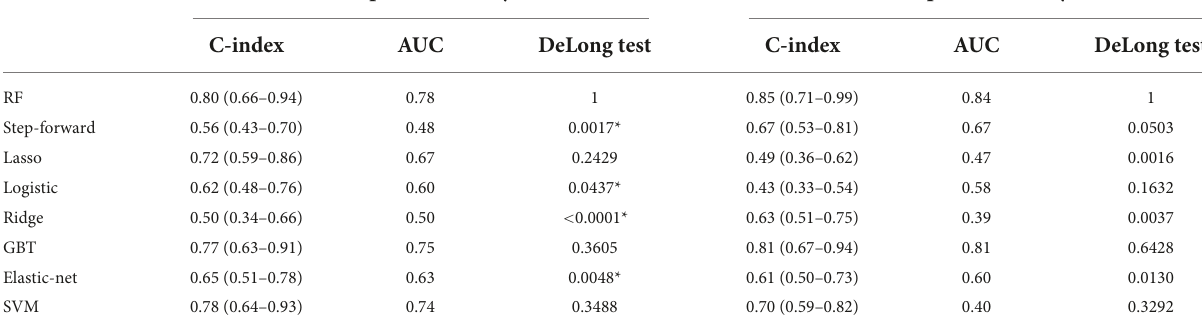
TABLE 3 Discrimination of the models for HF hospitalization.